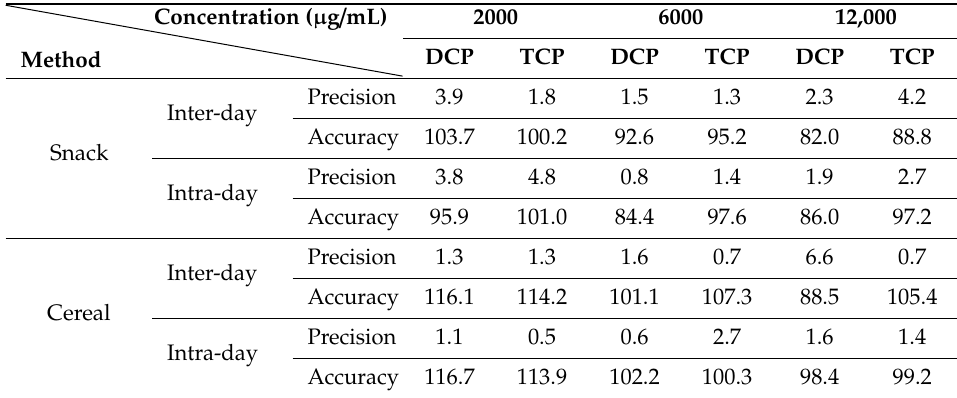
Table 2. Precision and accuracy determined from inter-day and intra-day tests of the snack and cereal